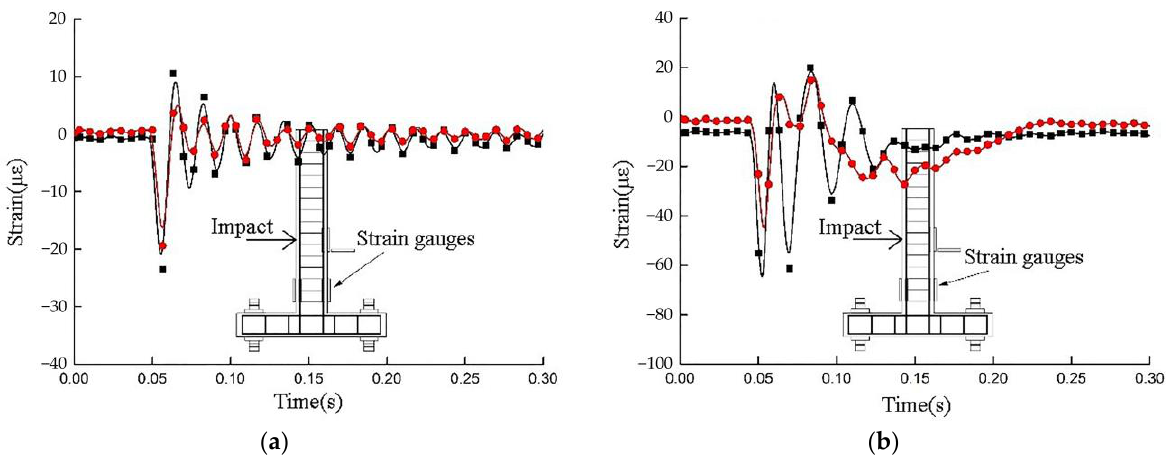
Figure 11. Strain time history of concrete of C_3 with nonaxial compression: ( a ) drop height = 30 cm and ( b ) drop height = 200 cm.